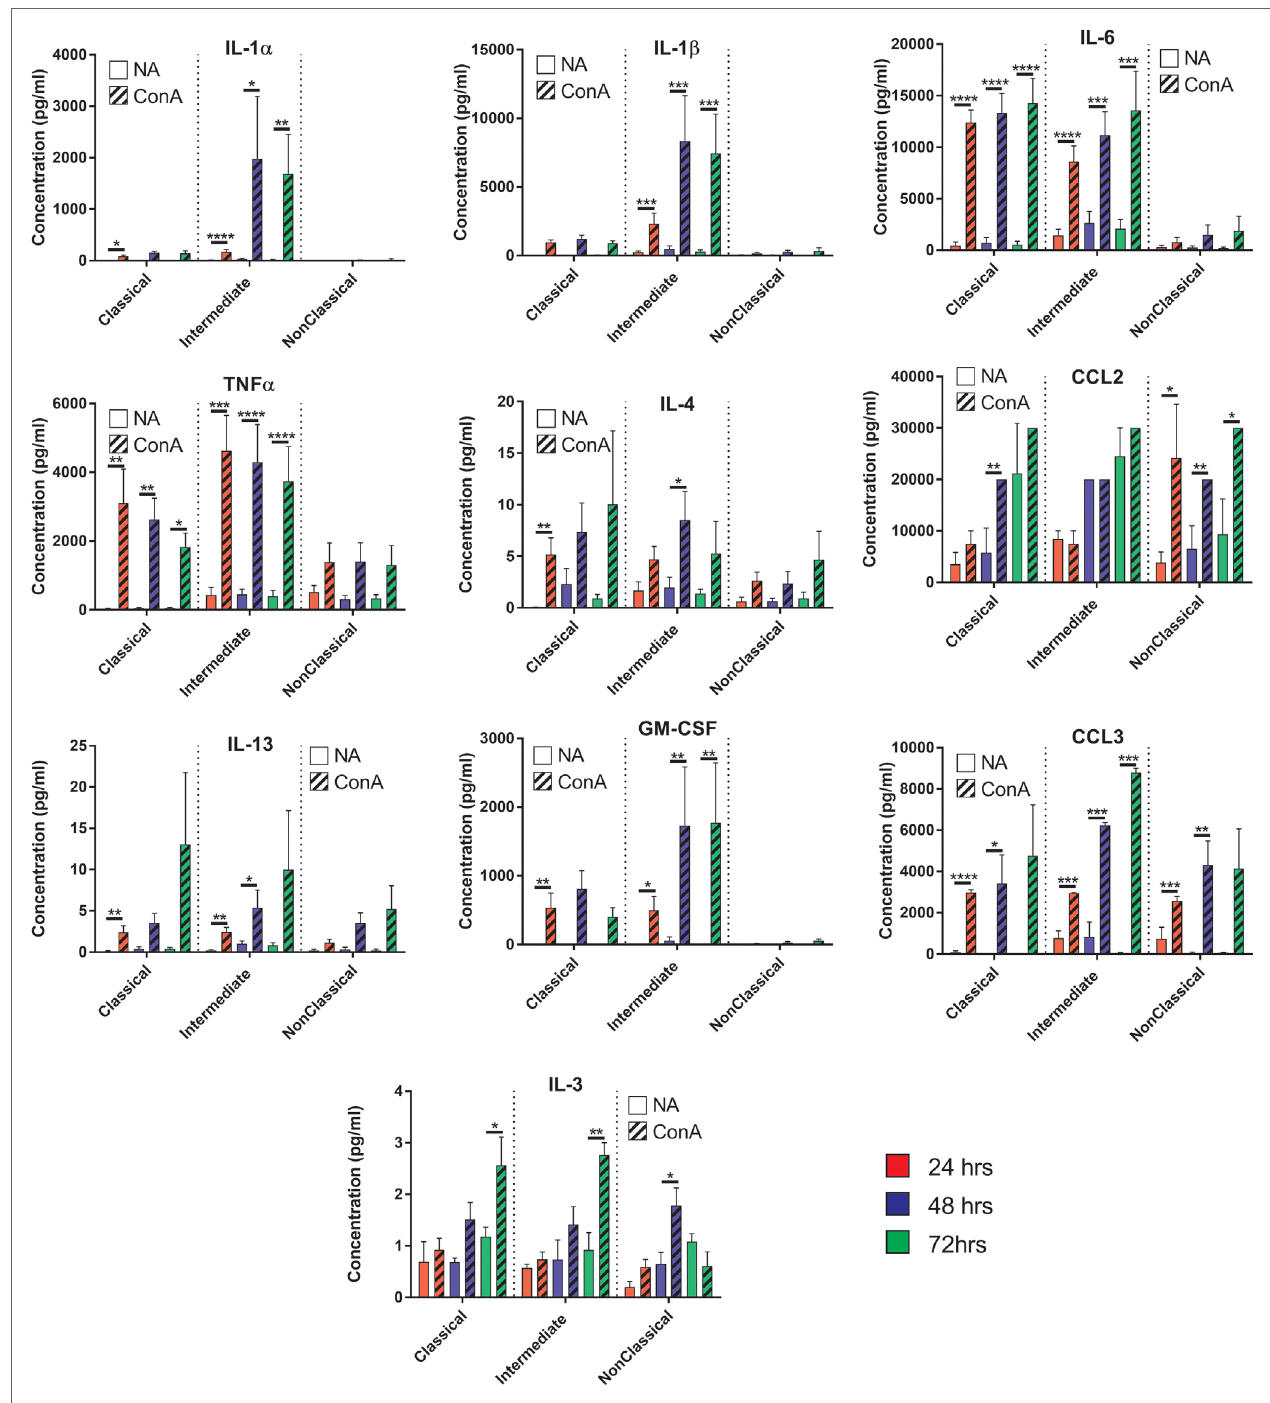
FigUre 10 | Cytokine production profiles during fusion do not correlate with fusion rate or giant cell morphology. Supernatants from the fusing monocytes were collected and analyzed by ELISA for 15 cytokines relevant to fusion. Clear bars: control (NA), striped bars: concanavalin A (ConA) treated; with each time point [24 (red), 48 (purple), 72 h (green)] presented in adjacent pairs. Bars represent means ± SEM, from eight separate experiments, all tested for significance with a two­ way ANOVA with a Sidak’s multiple comparison test comparing the means of control (NA) vs ConA treated monocytes at the same time point within each